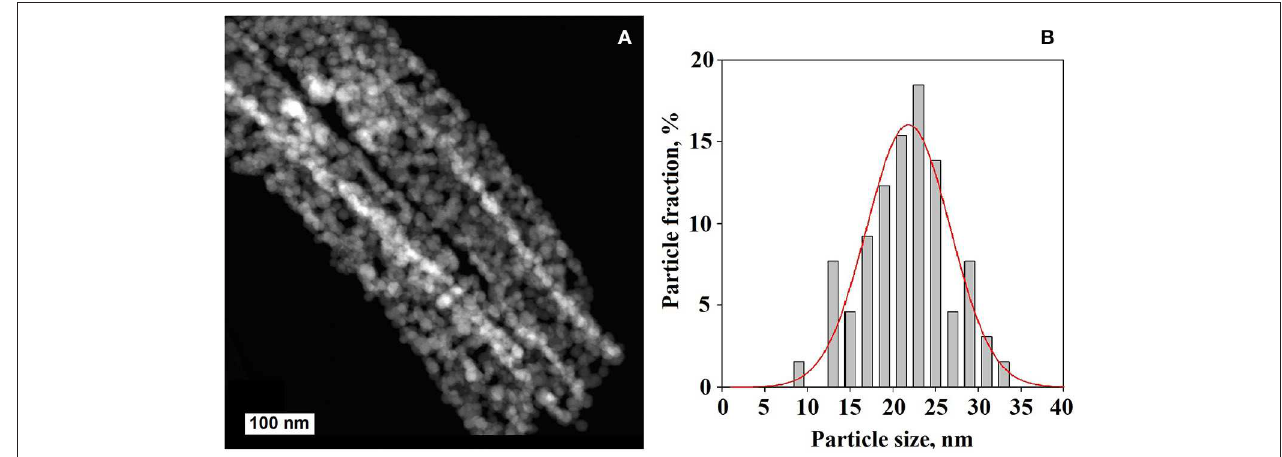
FIGURE 1 | HAADF-STEM image (A) and particle size distribution (B) of ZnO nanocrystalline